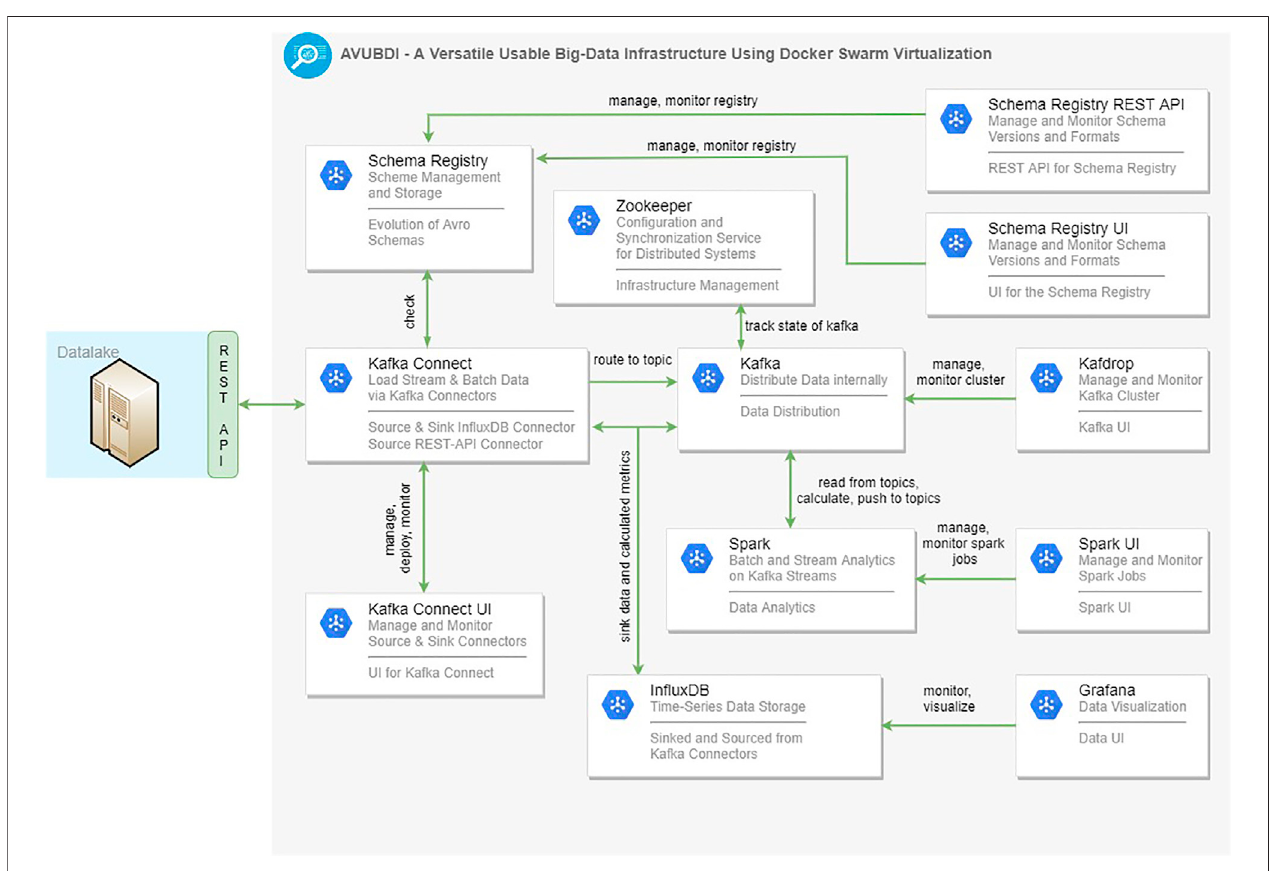
FIGURE 2 | Technology